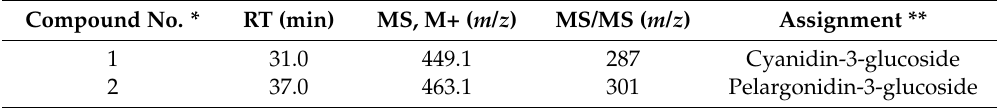
Table 2. Antioxidant activities of the ANT in Oryza sativa